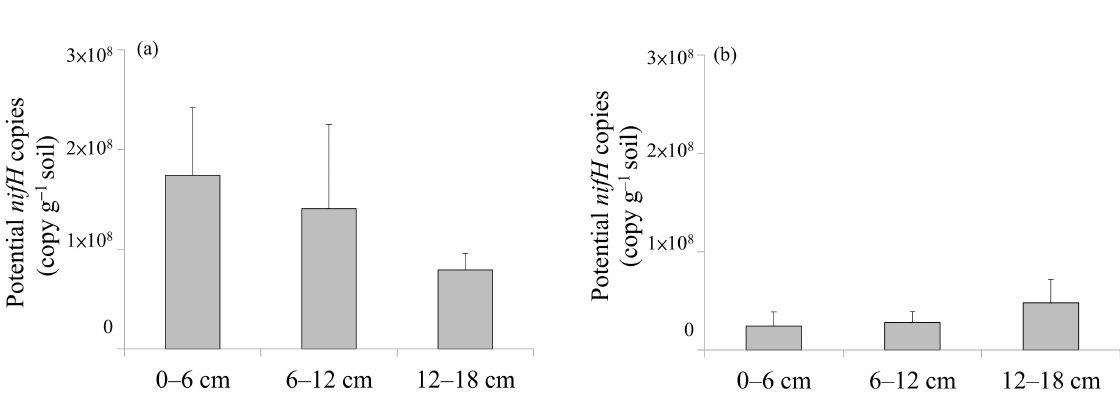
Figure 3. The soil maximum potential (amended with glucose) nitrogenase activities in Guandu ( a ) and Bali ( b ) mangrove forest soils, with and without amended MoO 4 , at the three soil depths. The height of bars and the error bars indicate the mean and standard deviation, respectively.